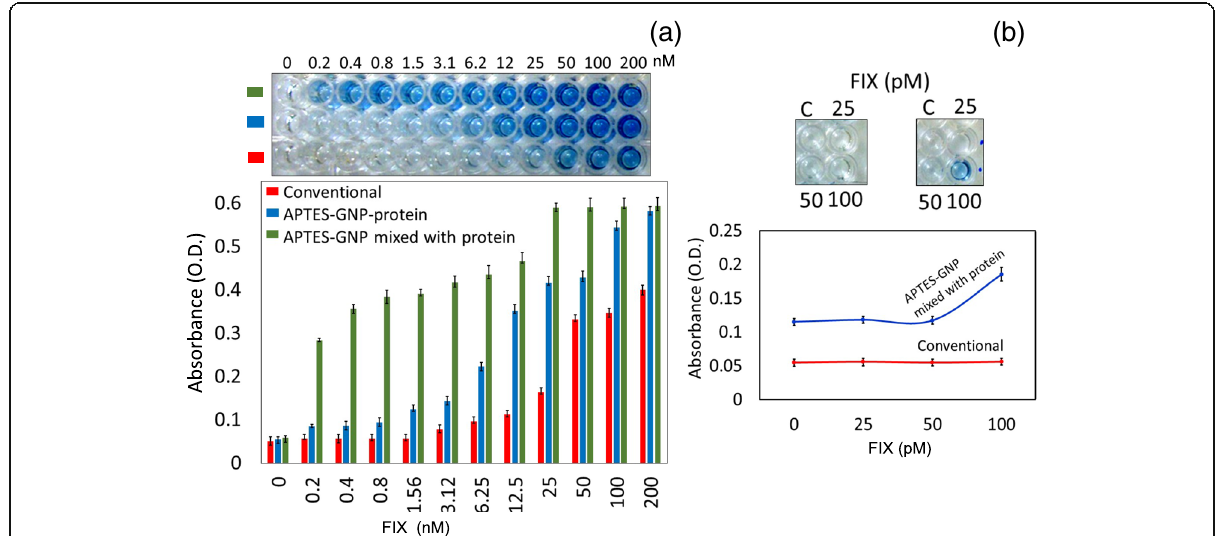
Fig. 5 a Comparing the sensitivity of FIX in GNP-modified ELISA against the conventional ELISA. FIX was titrated from 0.2 to 200 nM. Conventional ELISA exhibits the limit of detection of 6 nM. On the GNP-modified ELISA, the signal was observed until 200 pM. Figure inset displays the visual results. b Limit of detection of FIX on GNP-modified ELISA plate. FIX was titrated from 25 to 100 pM. The limit of detection was found to be 100 pM. Figure insets display the visual